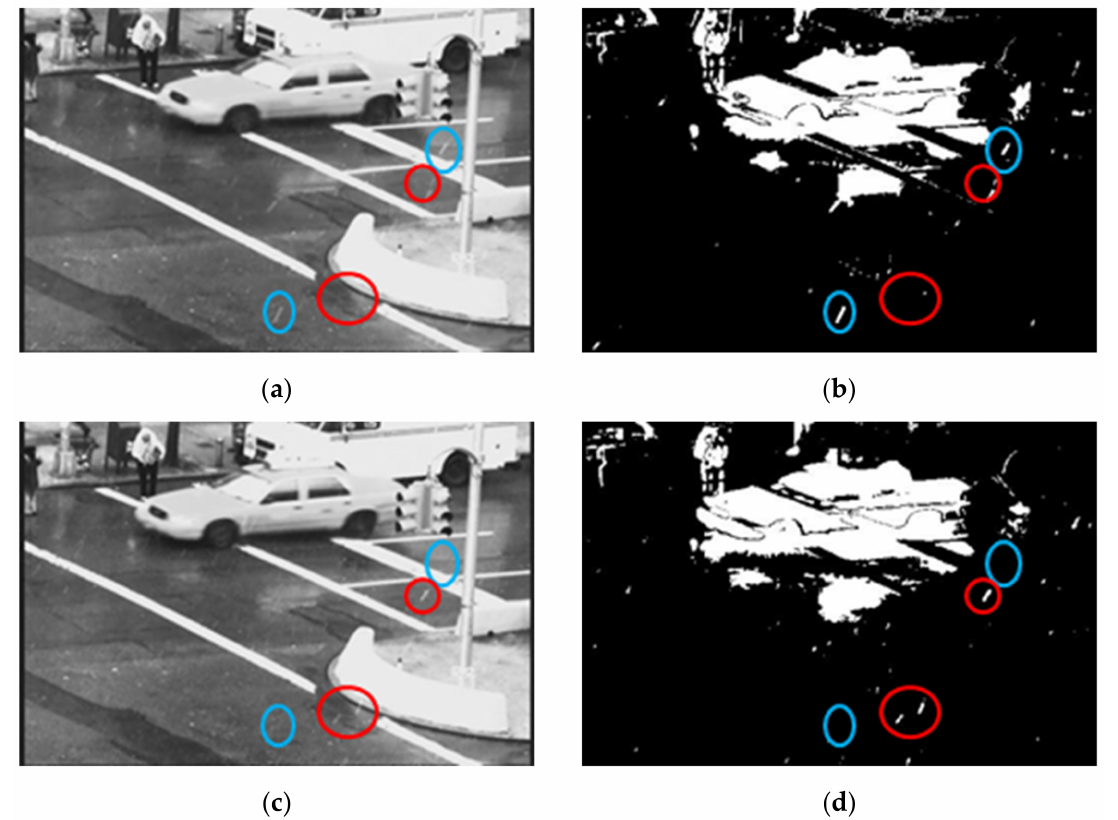
Figure 4. Observation of the temporal appearance property of the rain streaks in the “Traffic” video sequence. Blue and red circles show the appearance and disappearance of rain streaks in the same position. ( a ) input frame 79 ( b ) binary foreground of frame 79 ( c ) input frame 80 and ( d ) binary foreground of frame